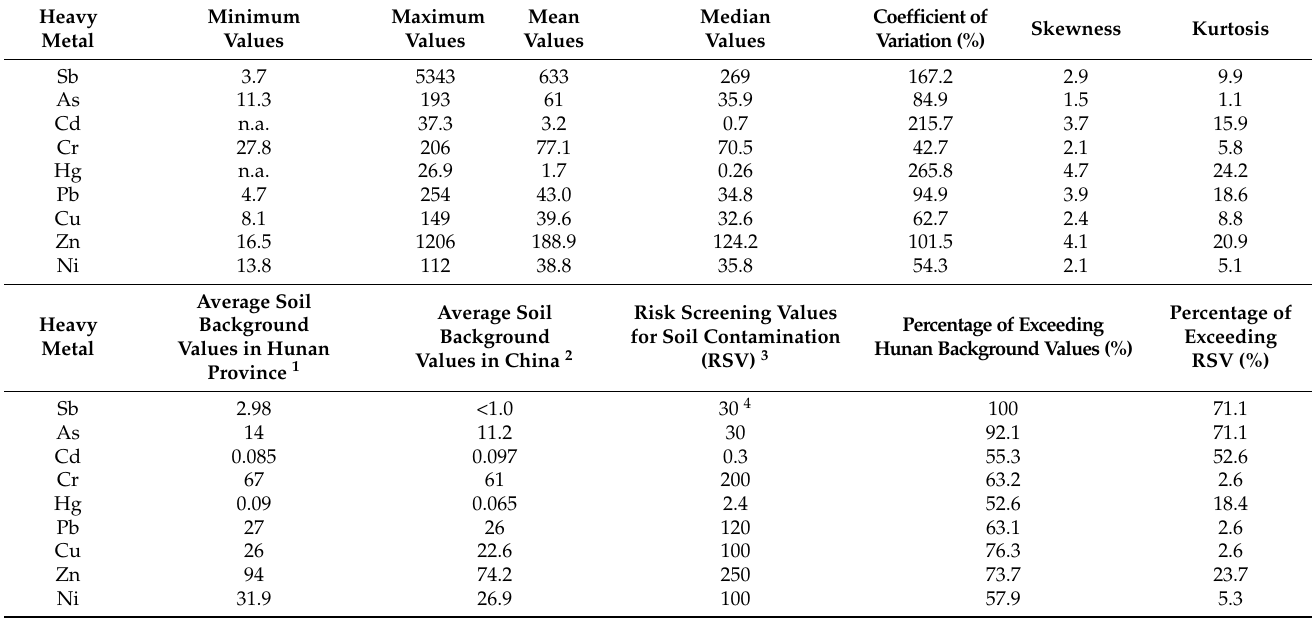
Table 1. Statistical data for soil heavy metal concentration (mg/kg) of the study area (n =